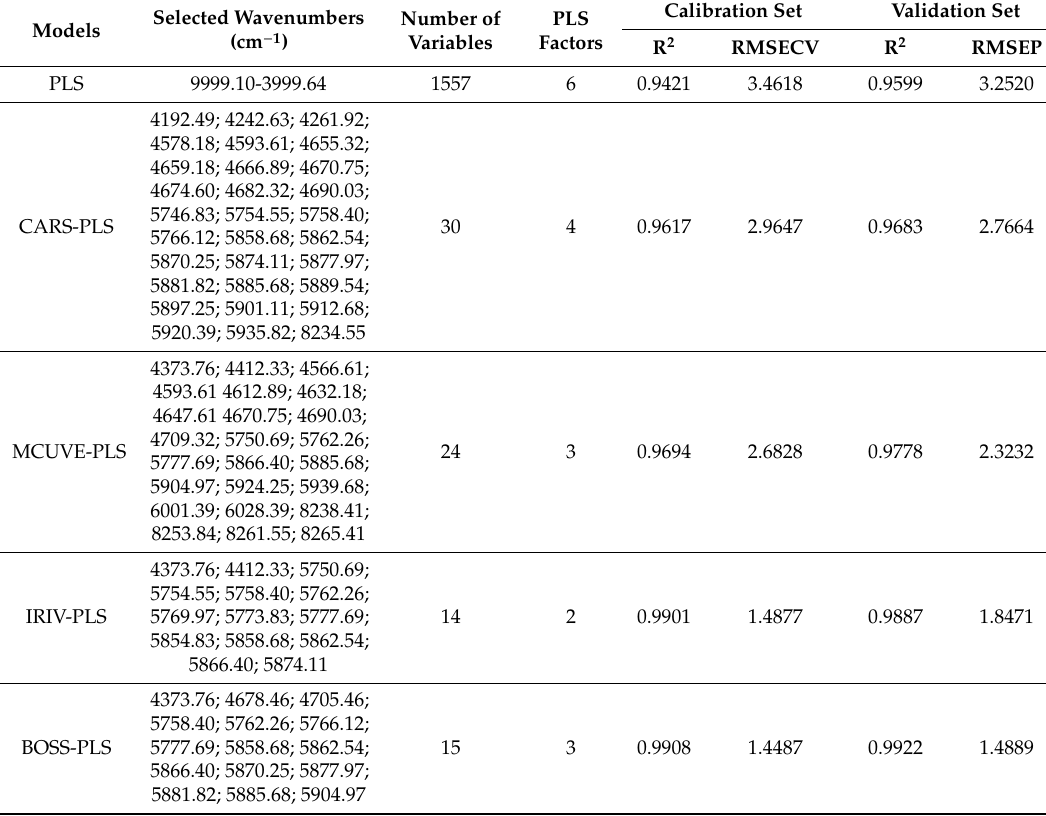
Table 1. Results of di ff erent partial least-square (PLS) models for the prediction of doping concentrations in EVOO. CARS: competitive adaptive reweighted sampling; MCUVE: Monte Carlo uninformative variable elimination; IRIV: iteratively retaining informative